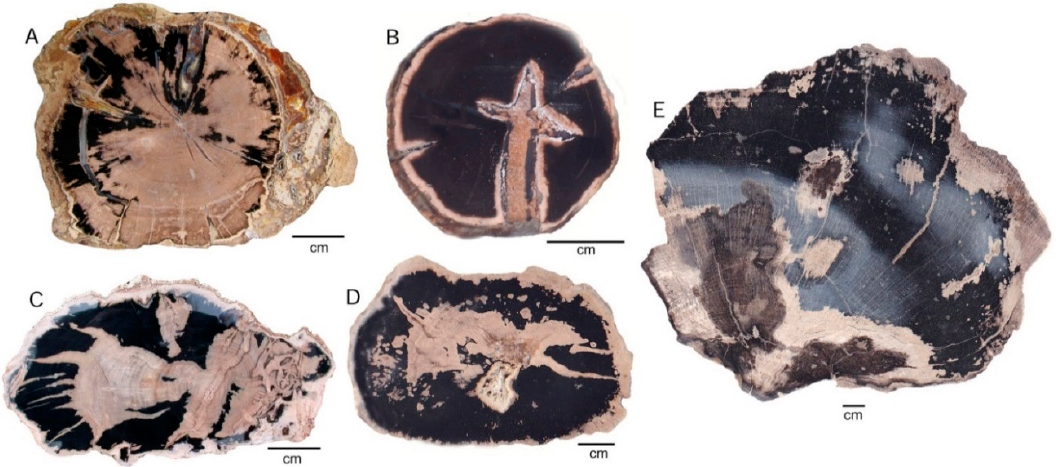
Figure 16. Bleached zones. ( A – E ) The dark color of the Blue Forest fossilized wood is caused by